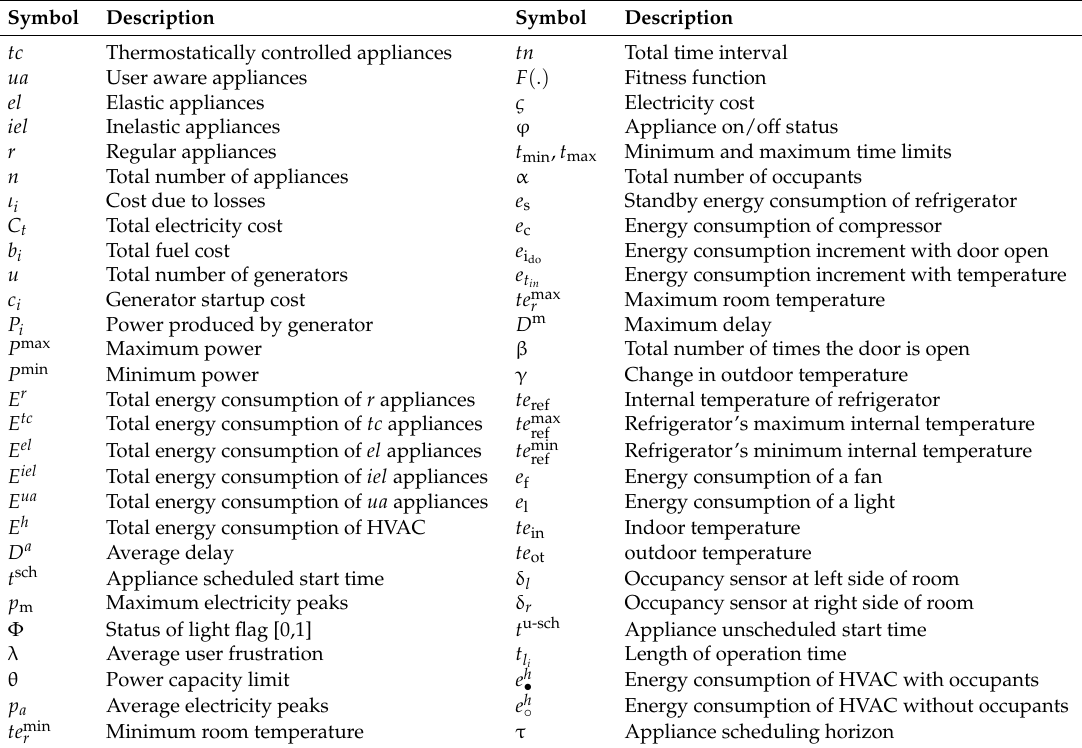
Table 1. Nomenclature. HVAC: heating ventilation and air